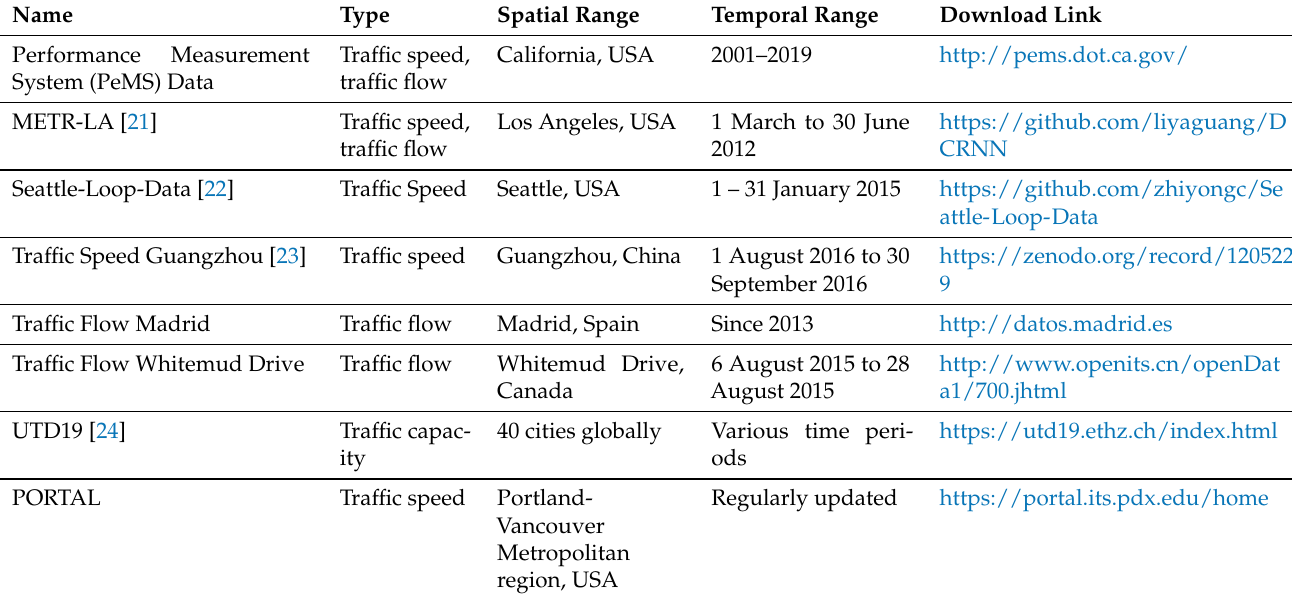
Table 2. The list of open road sensor